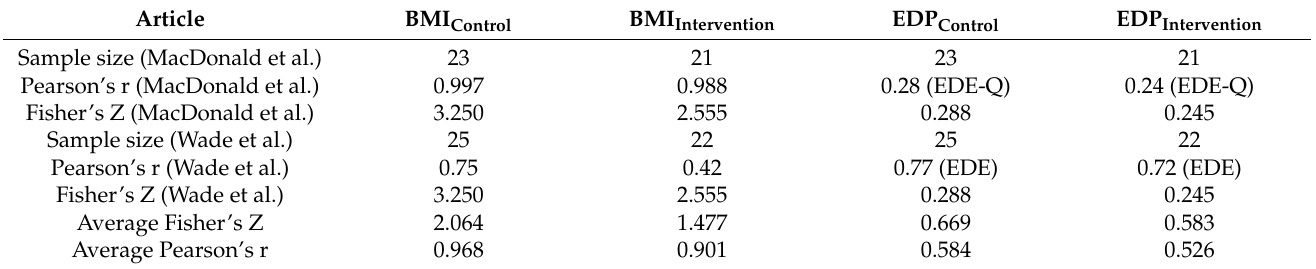
Table A2. The correlation coefficients (Pearson’s r). MacDonald et al. [29] used EDE-Q and Wade et al. [28] used